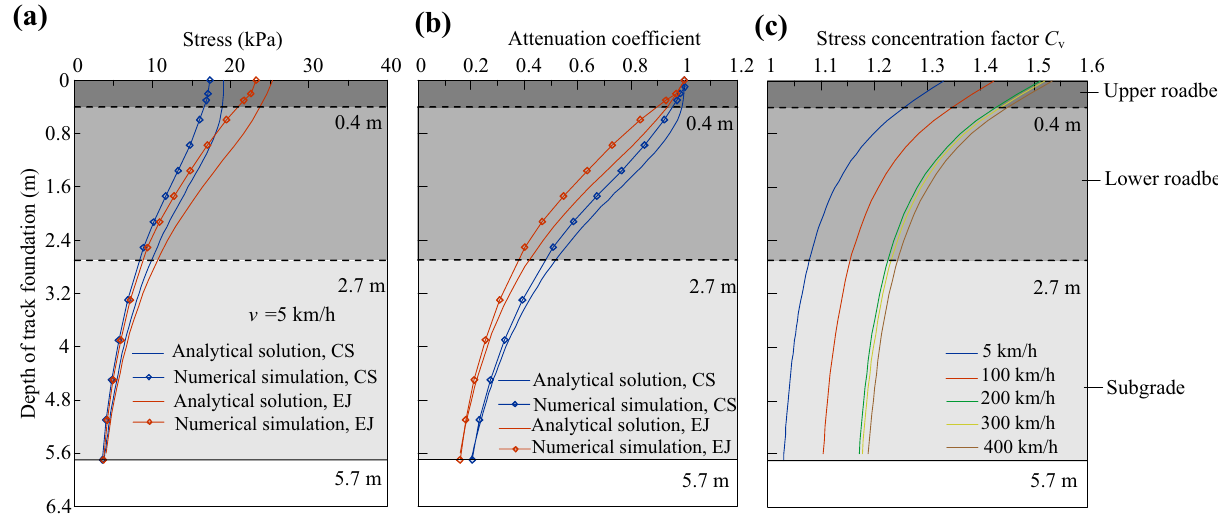
Fig. 14 Stress attenuation in track foundation of CRTS III slab tracks: a stress variation in depth from roadbed surface; b coefficient of stress attenuation; c stress concentration factor C v . CS represents the continuous structure, and EJ represents the expansion joints